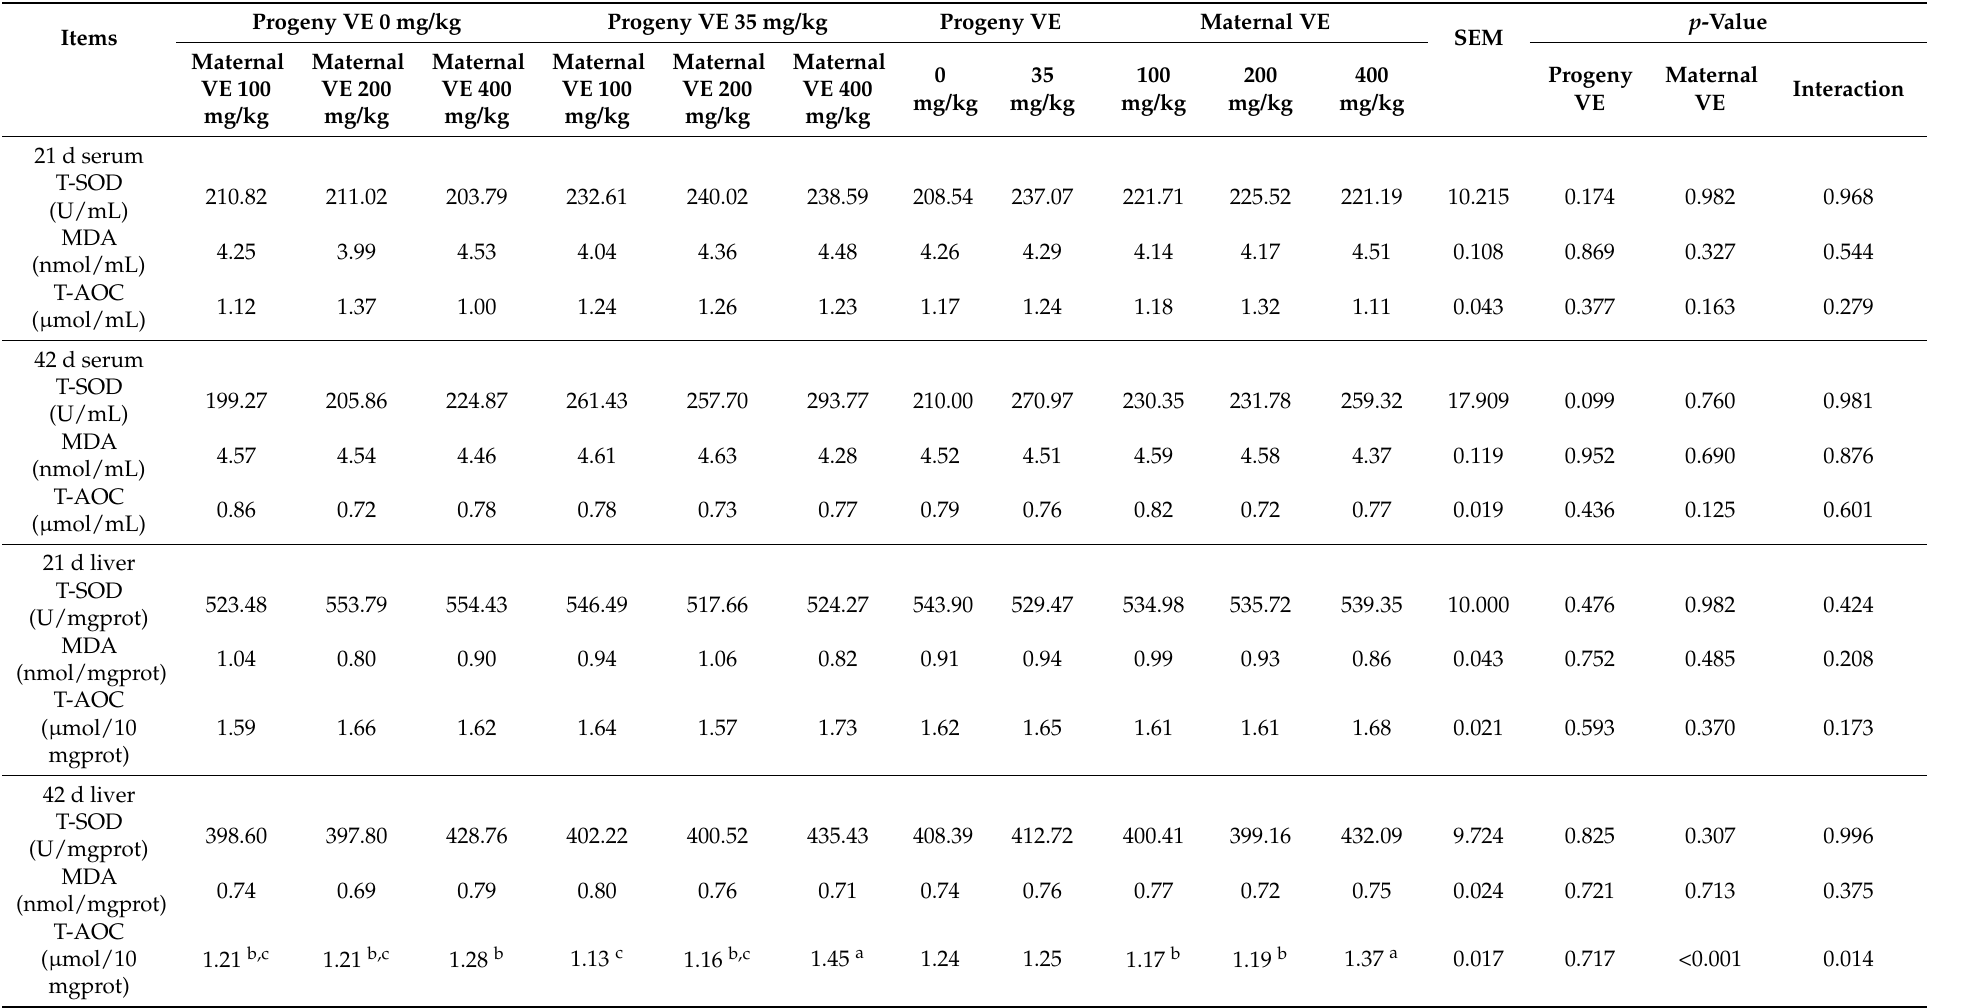
Table 3. Effects of maternal and progeny dietary vitamin E on the antioxidant status of offspring hatched from unstored eggs (trial 1) 1,2